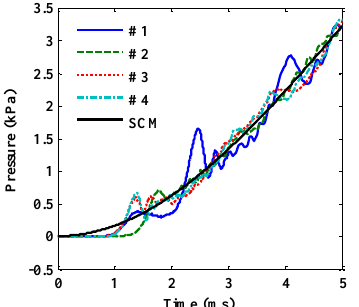
Figure 16. Change of the pressure with arc duration at different monitor points by computational fluid dynamics (CFD) and standard calculation method